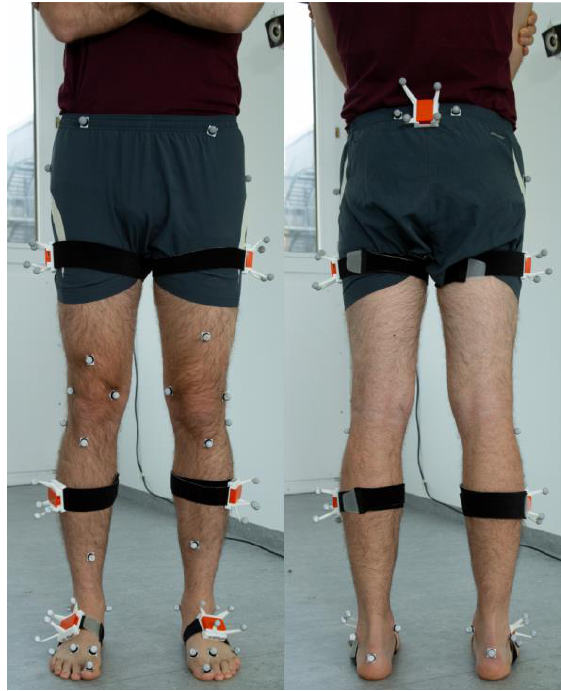
Figure 1. Schematic preparation of a subject with retroreflective markers and inertial measurement units (IMUs) inserted into rigid boxes equipped with additional markers. In the actual study, the markers on the pelvis were placed directly onto the skin. Furthermore, the subjects in the present study had to wear shoes.